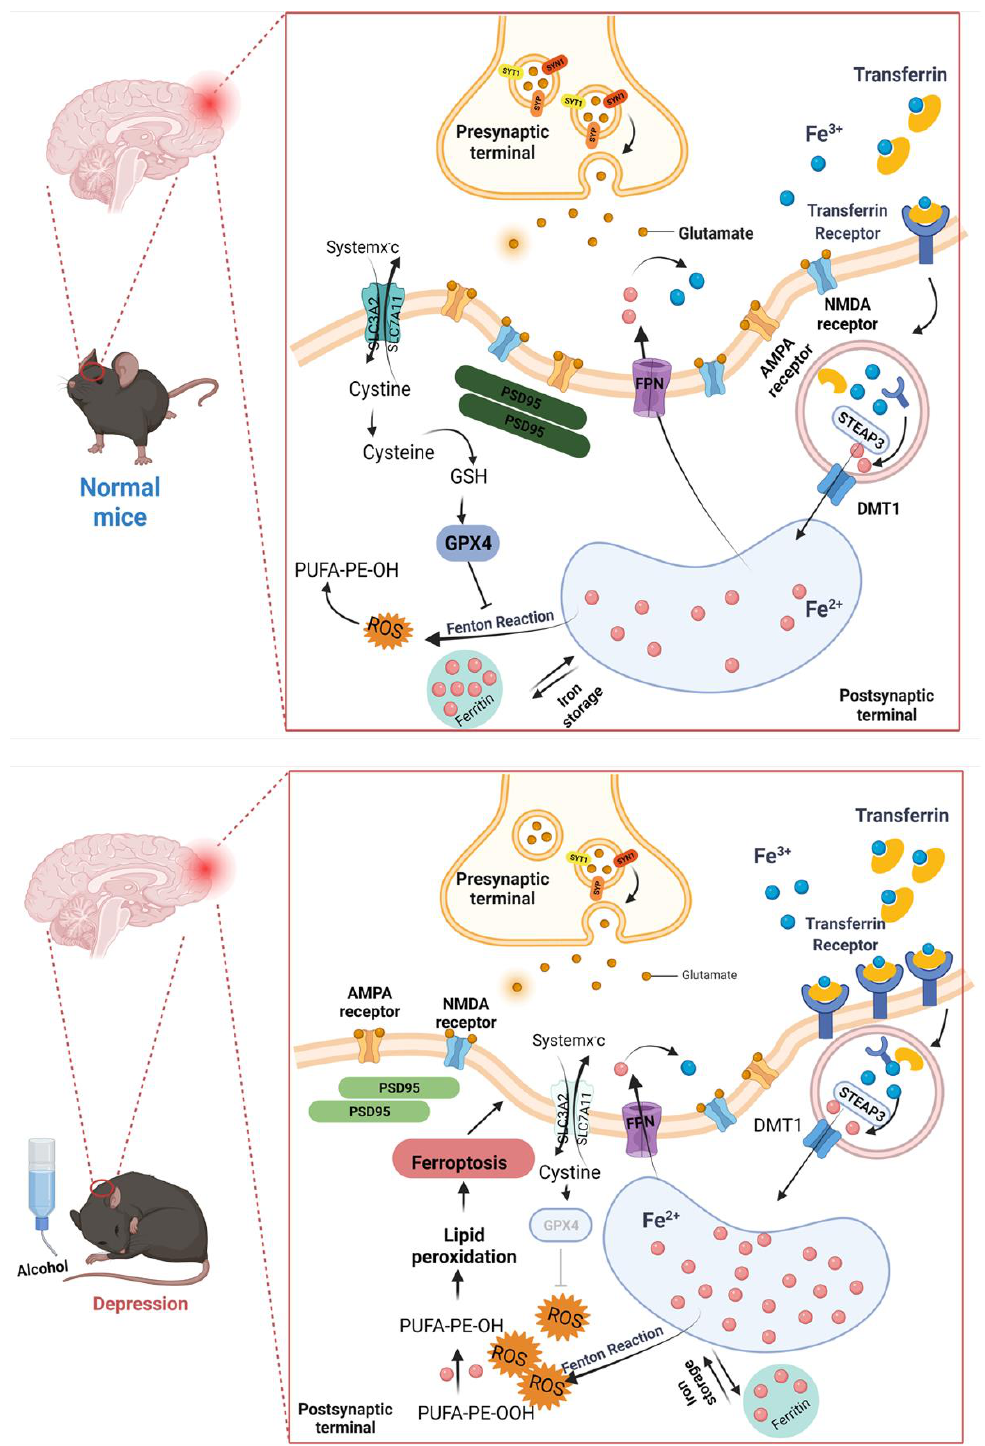
Figure 8. Mechanisms of ferroptosis that were involved in the depressive and anxiety-like behaviors in mice induced by alcohol exposure. in mice induced by alcohol